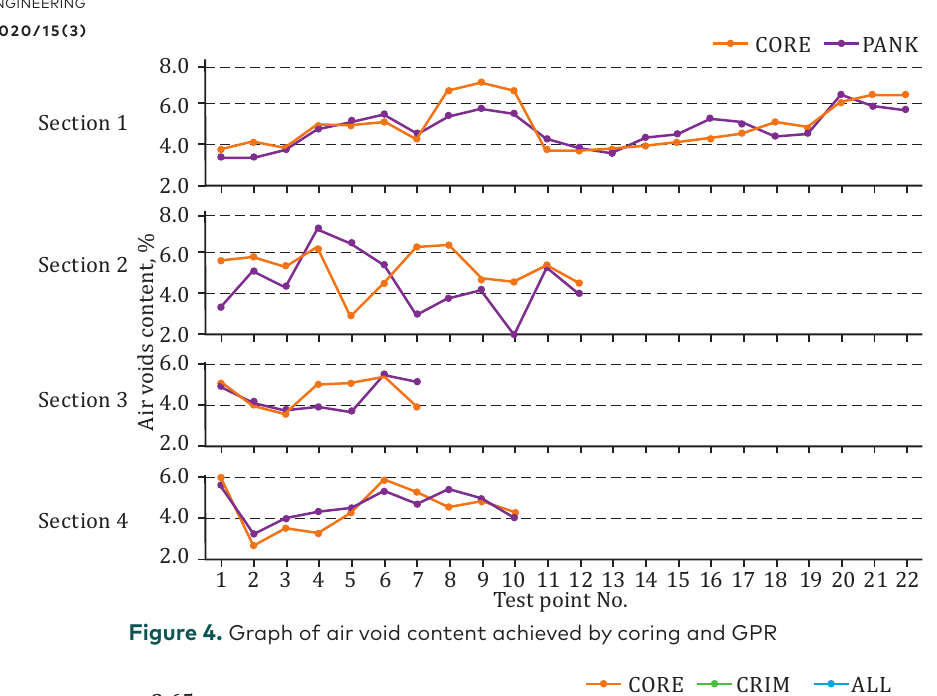
Figure 4. Graph of air void content achieved by coring and GPR